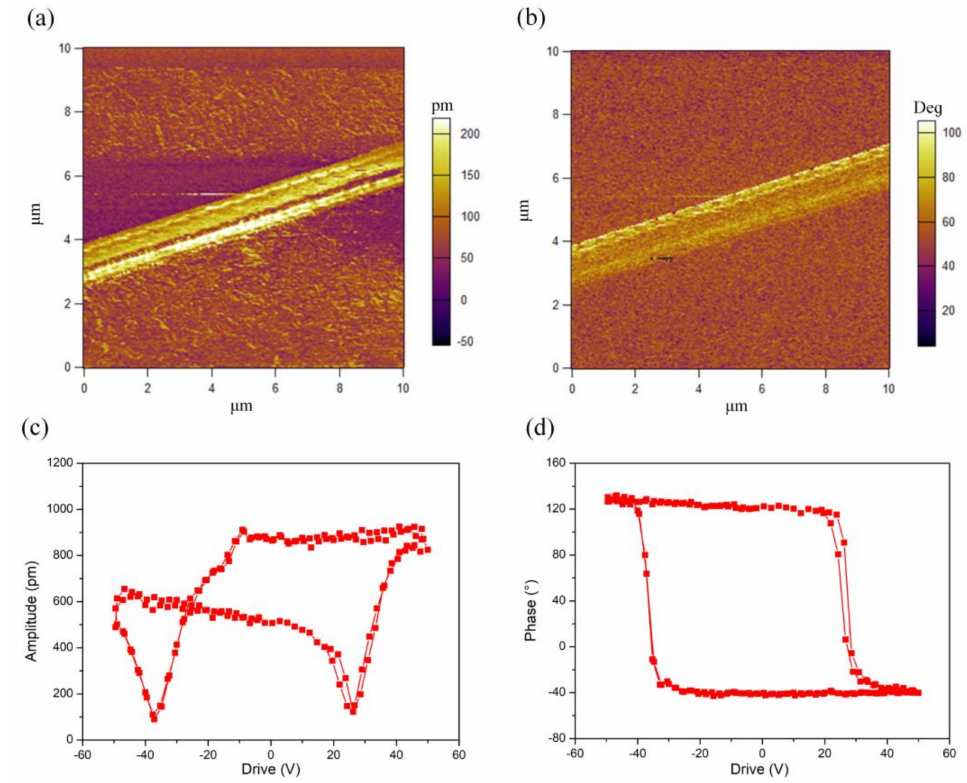
Figure 3. Piezoresponse force microscopy (PFM) images of a single P(VDF-TrFE) nanofiber. ( a ) Out-of-plane PFM amplitude image, revealing relatively uniform piezoelectric displacements over the entire nanofiber. ( b ) Out-of-plane PFM phase image, suggesting a uniform piezoelectric force response. ( c ) PFM amplitudes of the P(VDF-TrFE) nanofiber as functions of DC bias with two cycles, and ( d ) PFM Phases of the P(VDF-TrFE) nanofiber as functions of DC bias with two cycles, indicating a good repeatability for forward and reverse